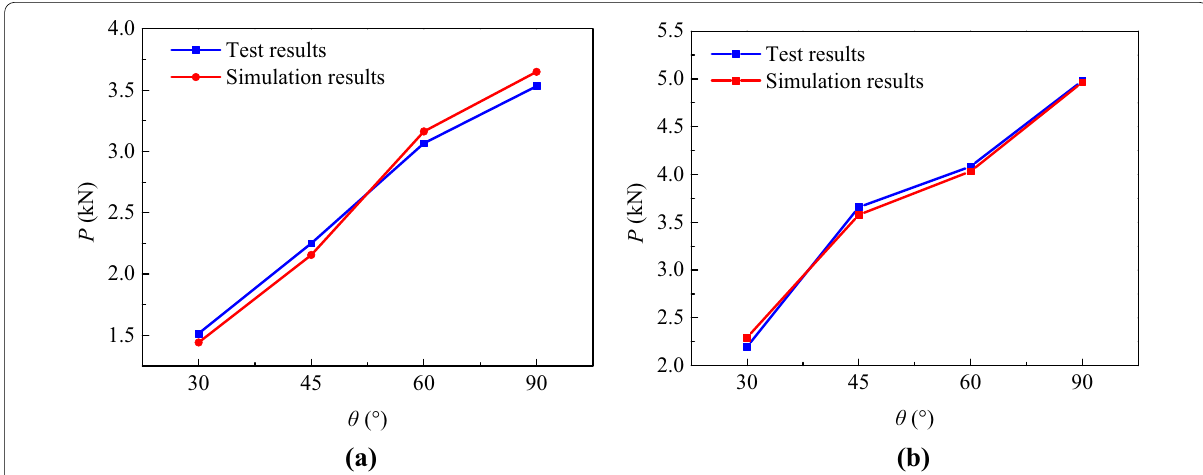
Fig. 19 Variation trends of the averages of P max for double‑crack specimens with different θ obtained by experiments and simulations ( a ) at the loading rate of 10 –3 mm/s and ( b ) 1 mm/s